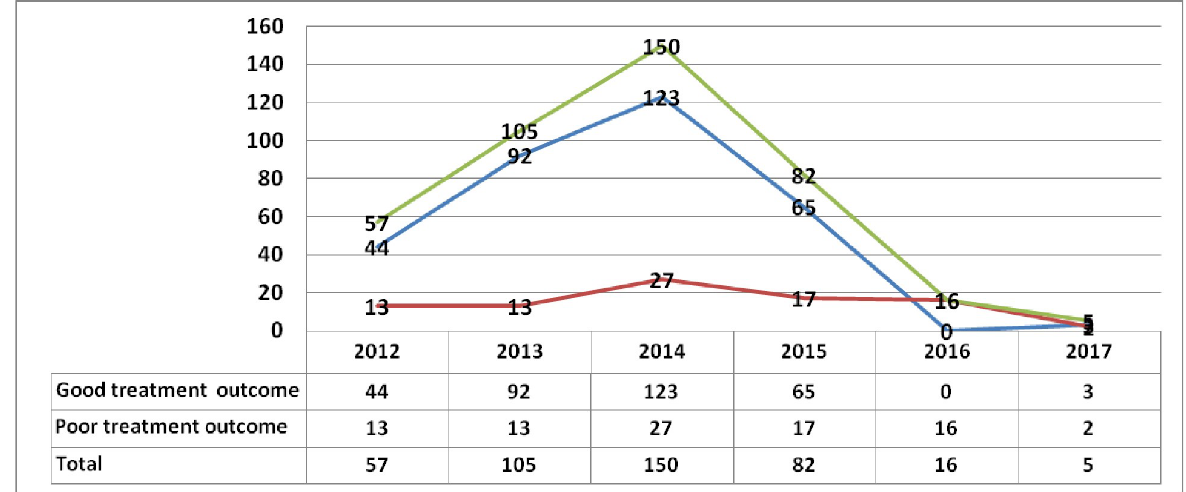
Fig 5. Trends of the number of MDR-TB patients, favorable treatment outcome and unfavorable treatment outcome at Oromia hospitals, Oromia Ethiopia.